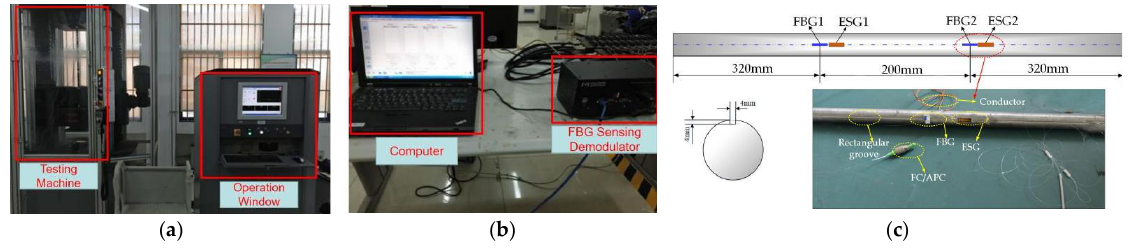
Figure 8. The diagram of the test device. ( a ) Electro-hydraulic servo testing machine; ( b ) FBG sensing demodulator and static resistance strain demodulator; and ( c ) the sample of the FBG dynamometry bolt.